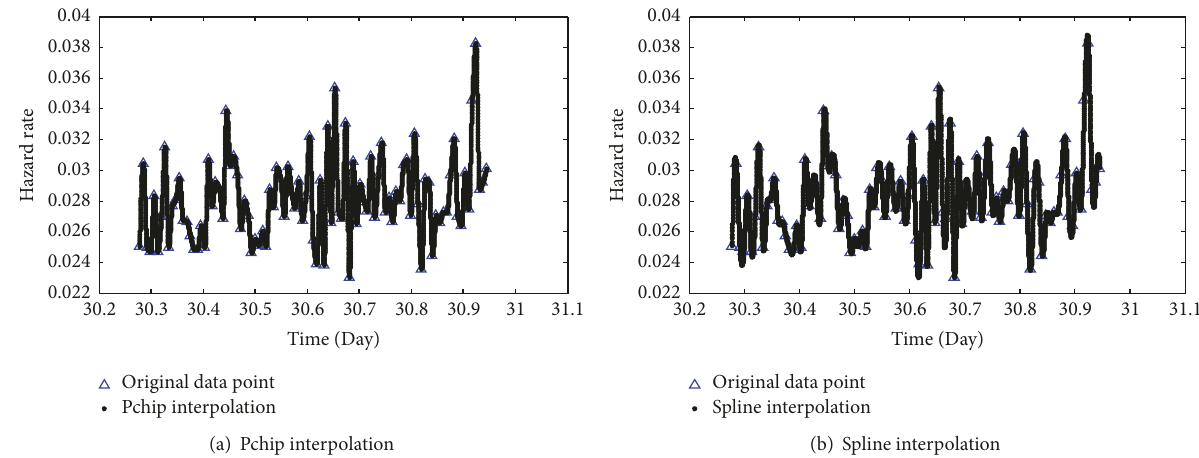
Figure 7: The comparison of interpolation results of period